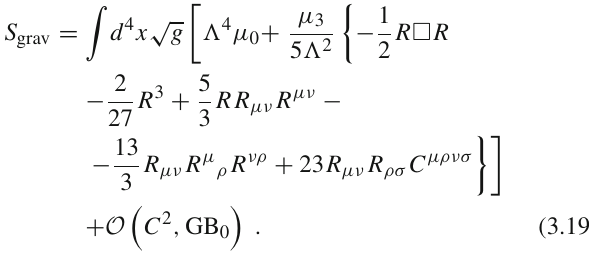
zeros for the three components E t t , E r r and E θ θ = E φ